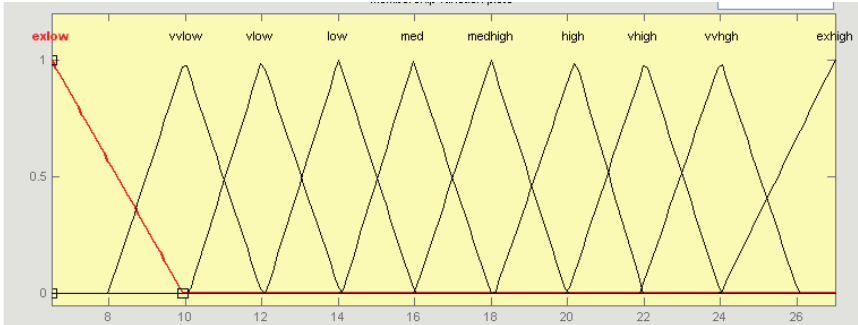
Figure 1. Fuzzy input membership functions for the parameter-panicle length (cm).